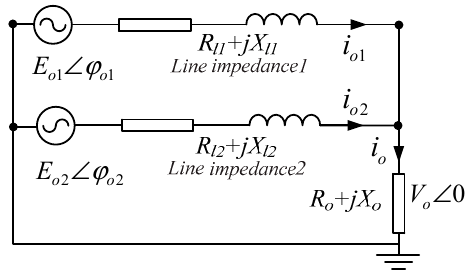
Figure 1. Diagram of inverter parallel system with two units considering line impedance.